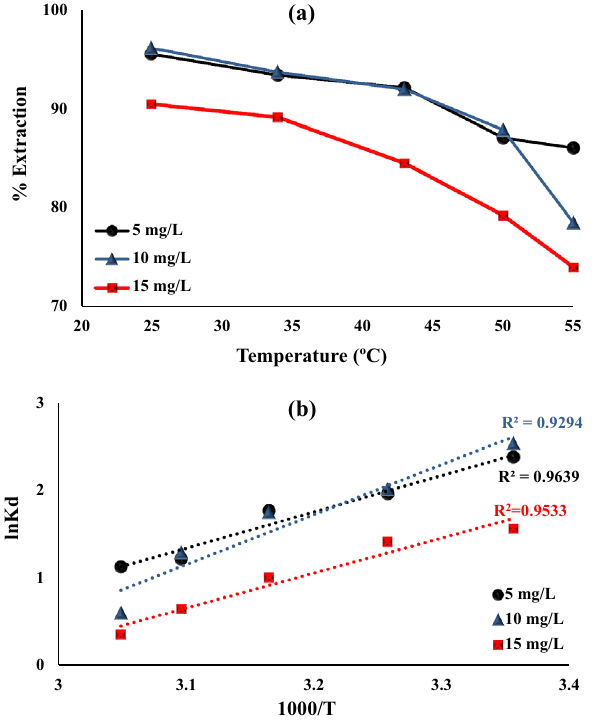
Figure 11. ( a ) Effect of temperature on Cr(VI) ions Fe 0.75 Cu 0.25 -BDC@Alg-MoO 3 /GO and ( b ) Van’t Hoff